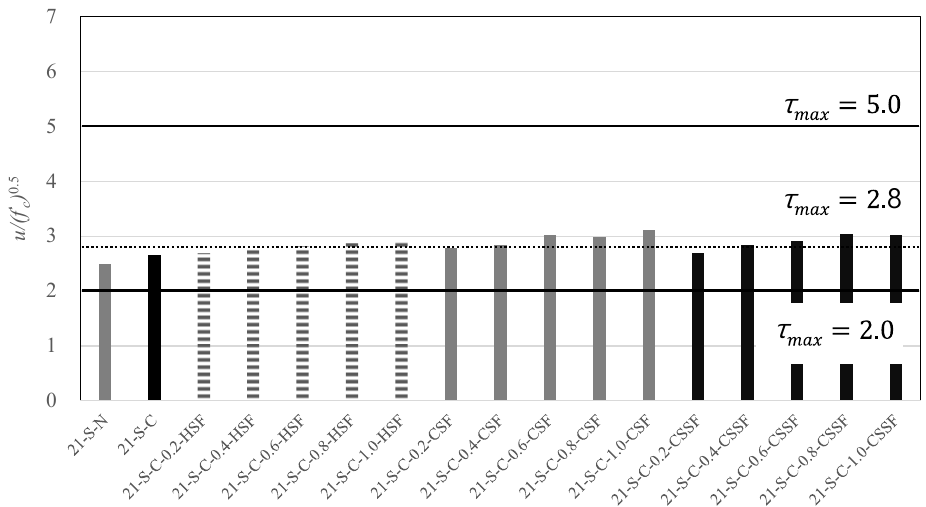
Figure 12. Normalized bond strengths of UHPC-coated steel rebars .